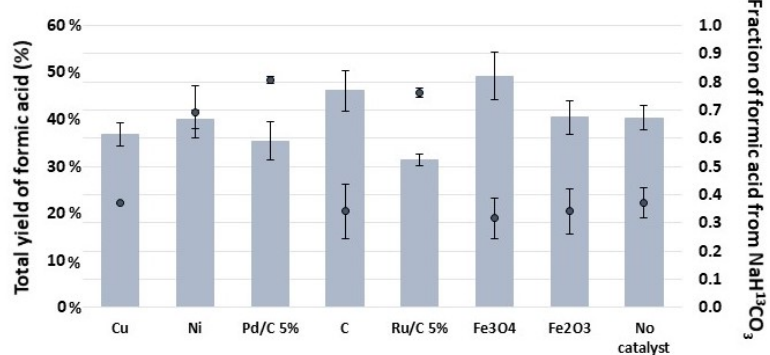
Figure 2. Fractions of formic acid coming from the reduction NaH 13 CO 3 and from the oxidation of glucose for each of the catalysts at 250 °C and 2 h. Gray bars represent the total yield of formic acid of each sample (obtained by HPLC); black dots represent the fraction of formic acid coming from NaH 13 CO 3 (obtained by 13 C ‐ NMR). The average error in the measure of the fraction of formic acid was 5%.